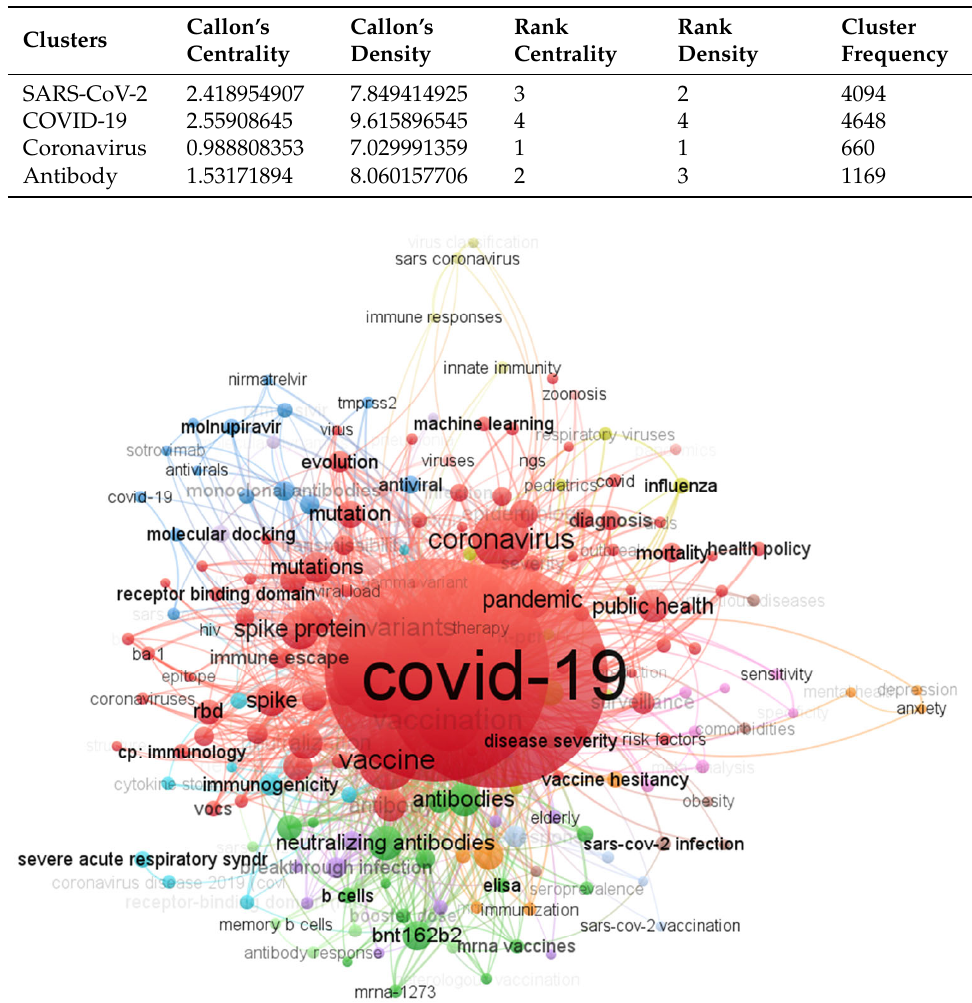
Figure 14. Thematic clusters of keywords in publications on the Omicron